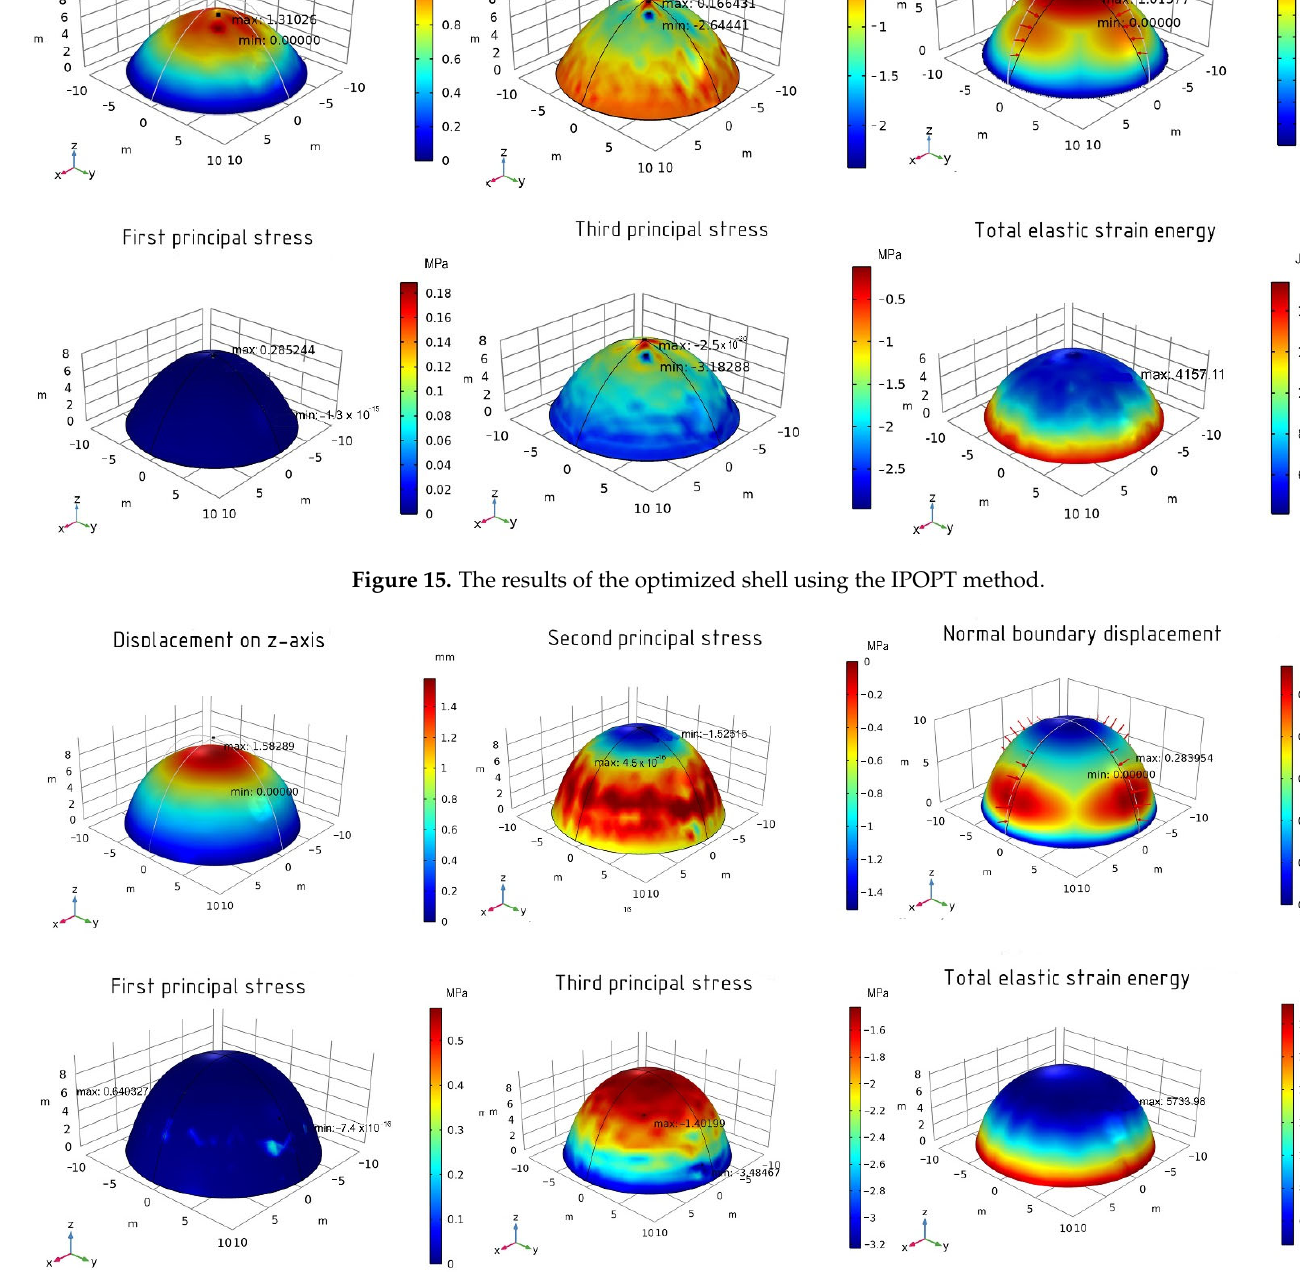
Figure 16. The results of the optimized shell using the MMA method. As for the total time of the optimization calculation, the fastest result was also obtained by using the SNOPT method (Table 2). It should also be noted that when choosing a fine element size, the calculations are performed faster when choosing any method. This can be explained by the fact that the second version of the computational model contains fewer element triangles than the first